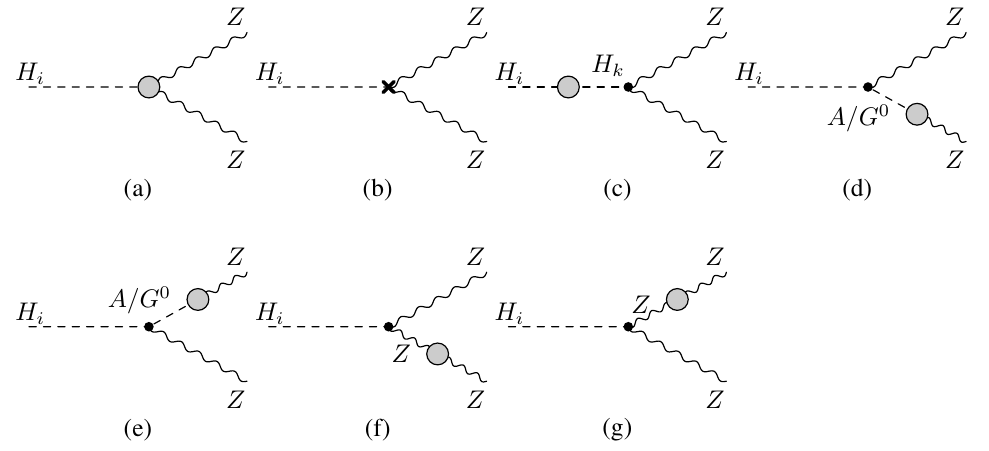
Figure 4 . Generic diagrams contributing to the virtual corrections of the decay H i ! ZZ : vertex corrections (a) and corrections to the external legs (c)-(g), where k = 1 ; 2 ; 3. Diagram (b) displays the vertex